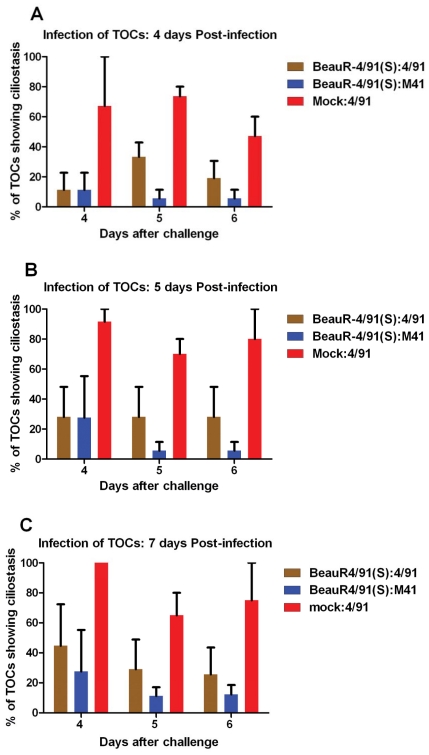
Ciliary activity levels displayed by TOCs infected with trachea-derived suspensions taken from birds infected with BeauR-4/91(S) and challenged with 4/91(UK) or M41-CK compared with non-vaccinated but challenged birds.Ciliary activity levels were significantly higher in BeauR-4/91(S):4/91 and BeauR-4/91(S):M41 groups when compared with mock:4/91 group on each day (p<0.05). Ciliary activity was observed on days 4 (A), 5 (B) and 7 (C) following infection of the TOCs. Each data point represents the average of the readings of TOCs infected with tracheal samples from three birds taken on days 4, 5 and 6 after challenge (average percentage of six TOCs per bird).